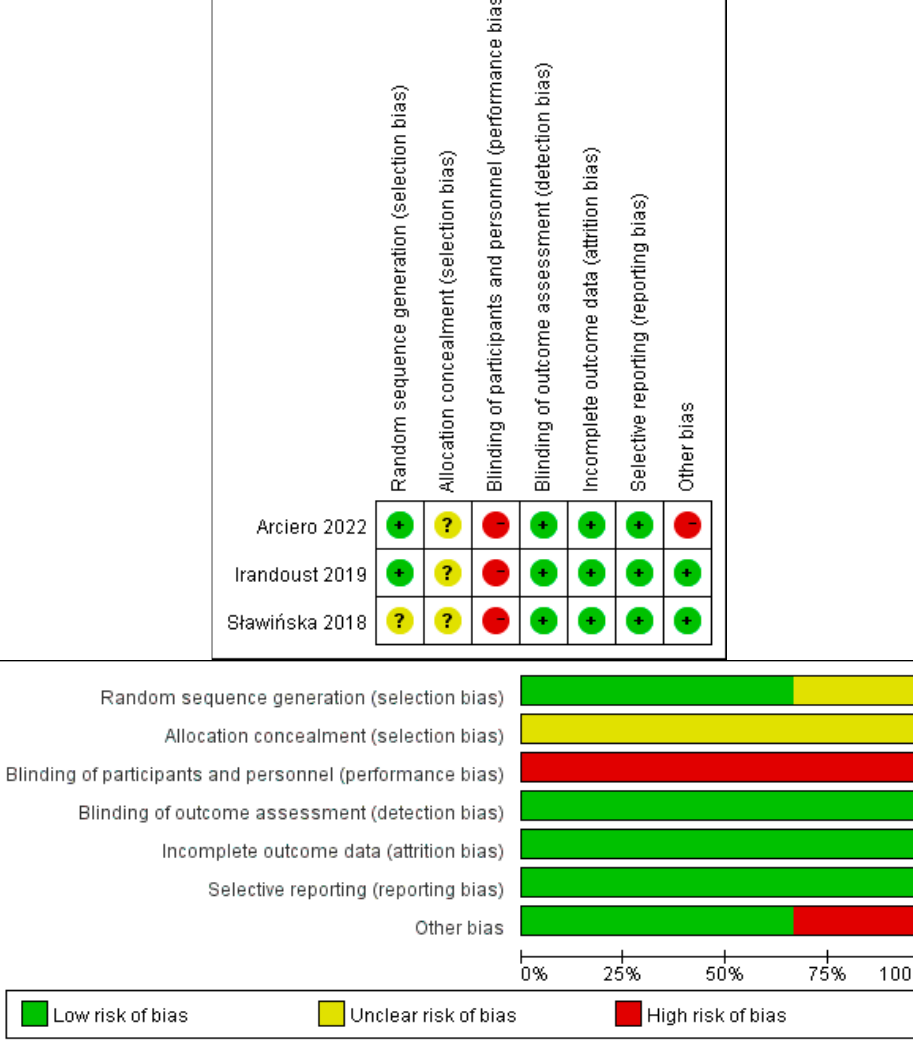
Figure 2. Risk of bias assessment for randomized controlled trials. Table 1. Risk of bias assessment for non-randomized controlled trials.